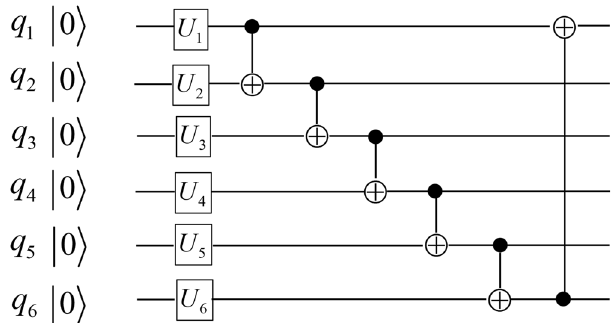
Fig. 5 The 1st example of the hardware-ef fi cient ansatz. The fi gure shows the quantum circuit of one layer of the hardware-ef fi cient ansatz in ref. 33 U U 1 through 6 are 1-qubit unitaries applied to the qubits respectively. The CNOT gate layer then copies the unitary dependencies around the qubits. The fi nal unitary dependence picture as described in Eq. (10) shows the qubits are highly-dependent on manipulations and measurement